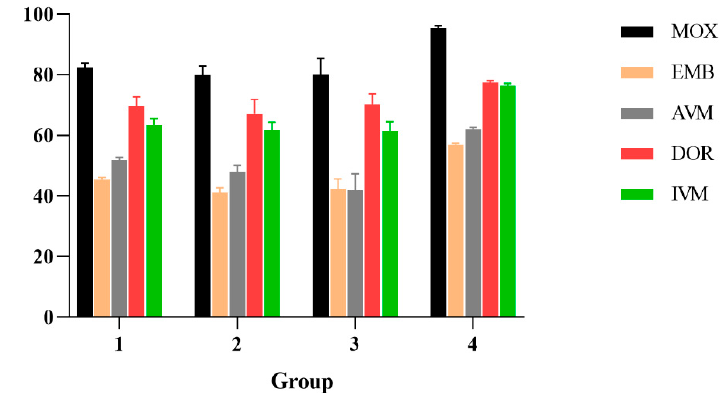
Figure 1. The influence of different mobile phase additives on the peak area of 100 µ g/kg standard AVMs. 1: MeOH: ACN (1:1, v / v ) with 0.1% formic acid; 2: acetonitrile and aquatic 0.1 mM ammo ‐